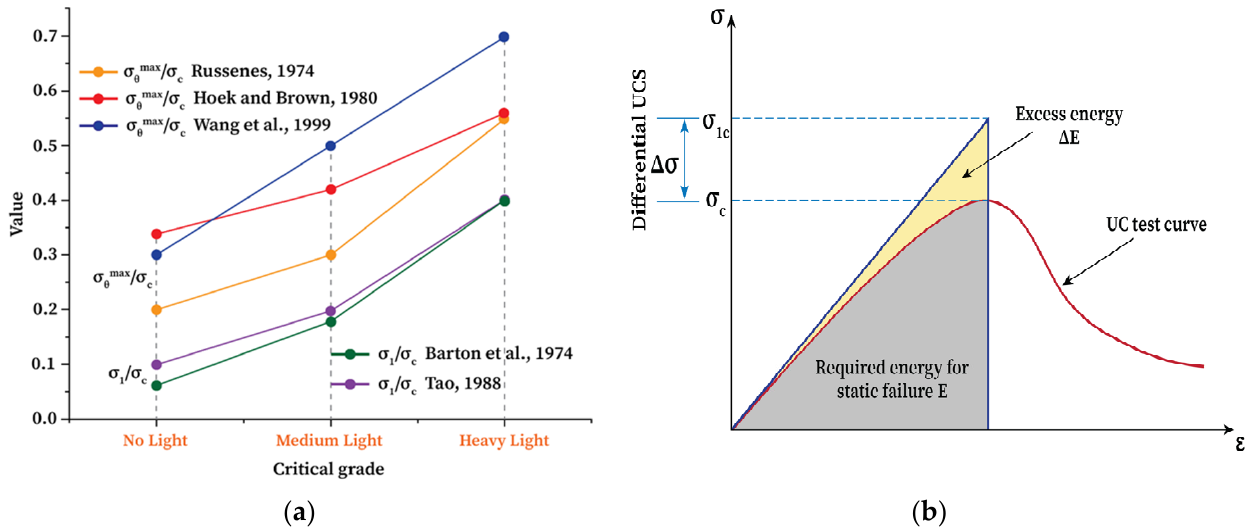
Figure 3. ( a ) Rockburst intensity divisions based on different strength criteria (modified from ref. [71]). ( b ) Energy model of strainburst (modified from ref. [54]).